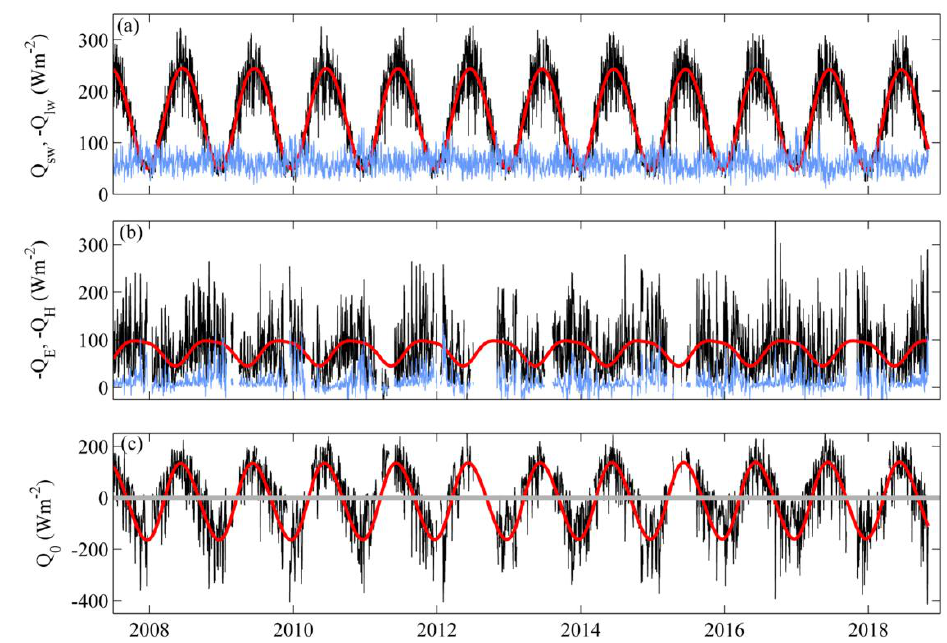
Figure 2. Air-sea heat fluxes registered by the oceanic-meteorological buoy (AGL) buoy since its deployment in June 2007. ( a ) Short (solar, Qsw) and long-wave (Qlw) radiative heat flux components (black and blue lines, respectively) obtained from NCEP / NCAR Reanalysis. ( b ) Latent (Q E ) and Sensible (Q H ) turbulent heat flux components (black and blue lines, respectively) estimated from AGL buoy data. Qlw, Q H , and Q E are expressed as heat loss by the ocean surface (heat loss implies negative values and are represented as − Q lw , − Q E , and − Q H for clarity). ( c ) Net heat flux (Q 0 ) as a result of the sum of radiative and turbulent heat flux components. Red lines in ( a – c ) show the climatological seasonal cycles of Qsw, Q E , and Q 0 through Fourier decomposition.